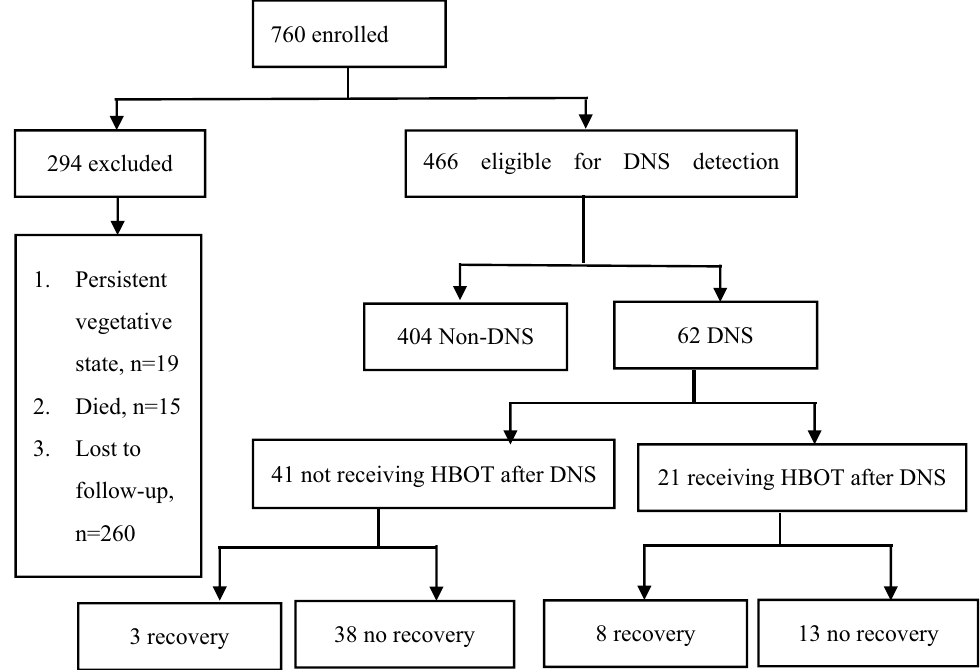
Figure 1. Study flowchart [Microsoft Word (v.2106, 2020, Office 365, Microsoft Corporation, Redmond, Washington,